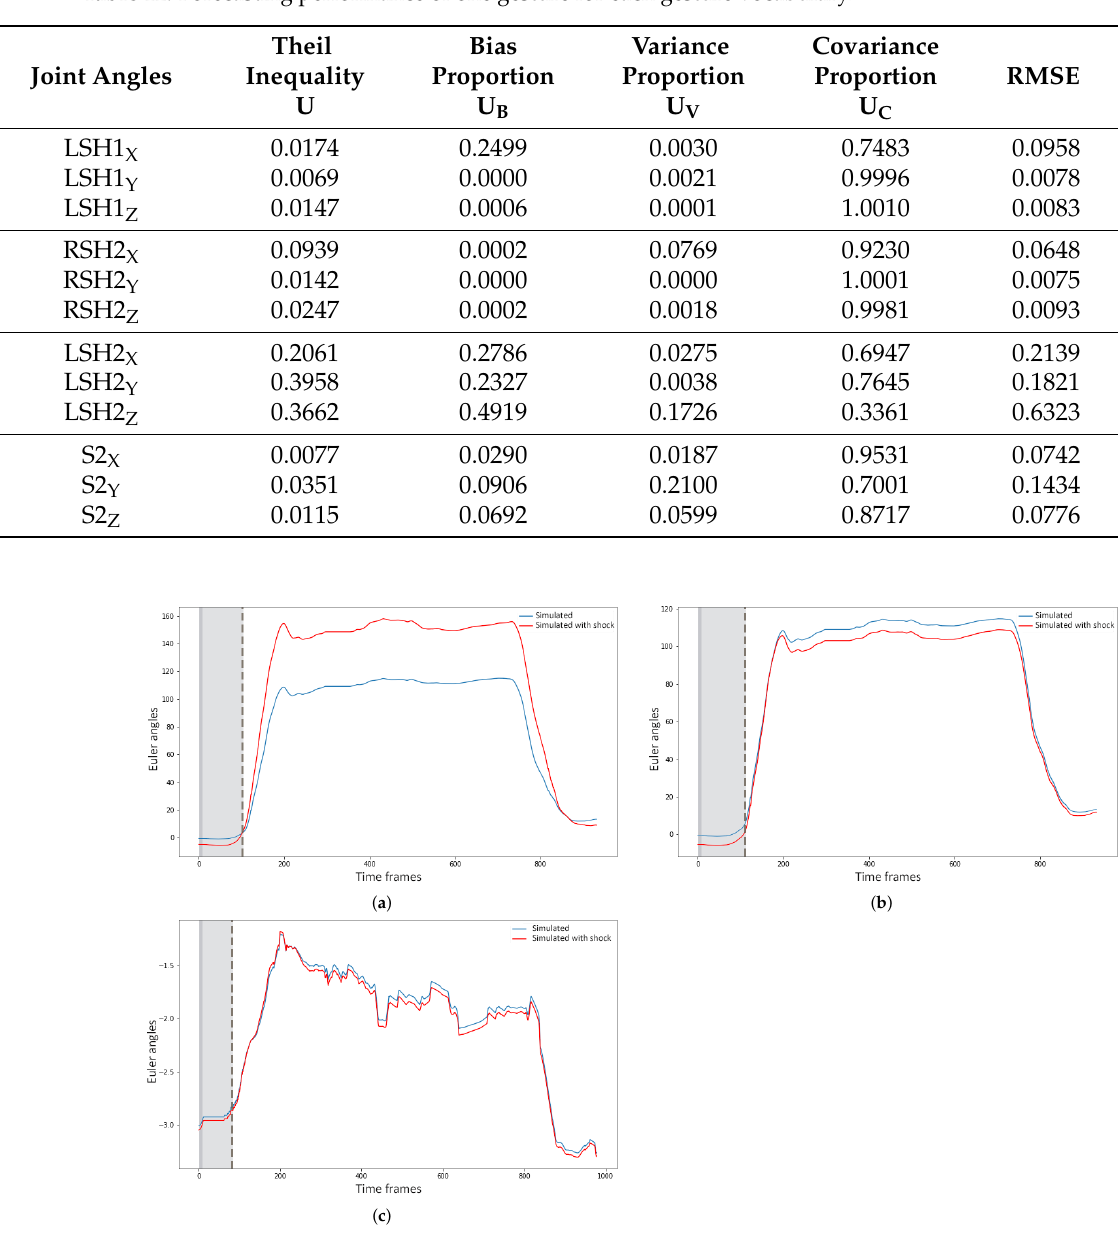
Figure 9. Simulated joint angles with and without disturbance of 80% on the two initial time frames. ( a ) Simulation of the joint angle LA X with a disturbance on the joint angles of LSH2 (blue) and without (red); ( b ) Simulated joint angle sequence of LA X with a disturbance on the joint angles of RSH2 (blue) and without (red); ( c ) Simulation of the joint angle S2 Y with a disturbance on the joint angles of H (blue) and without